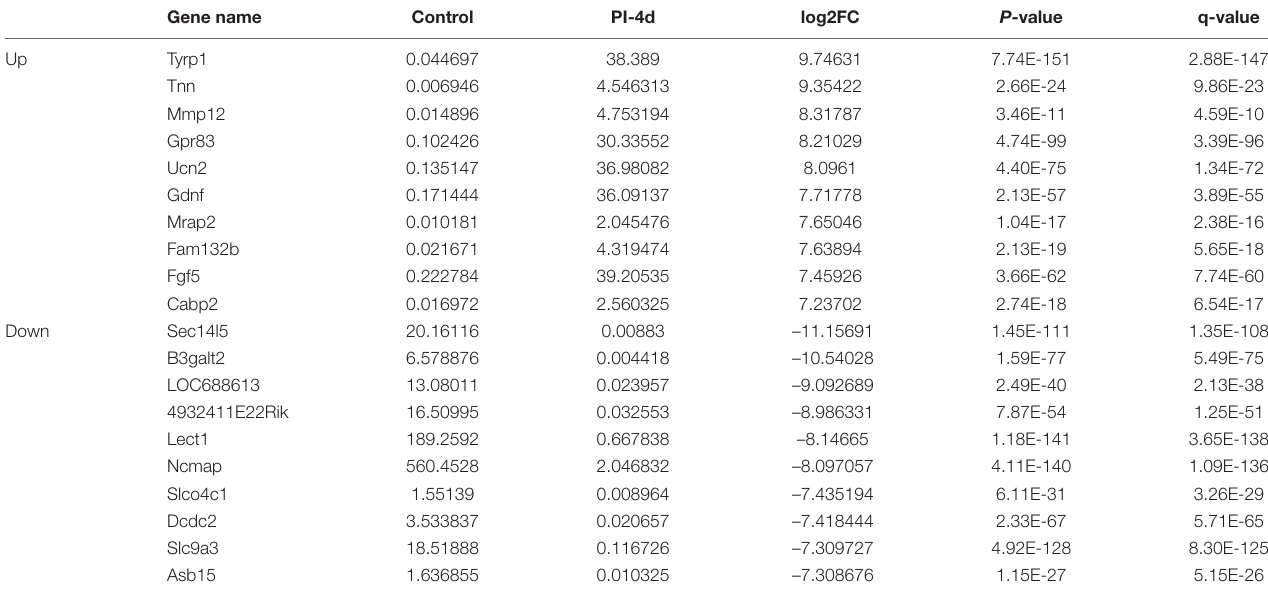
TABLE 3 | Top 10 up/down regulated DEmRNAs 4 days after crush